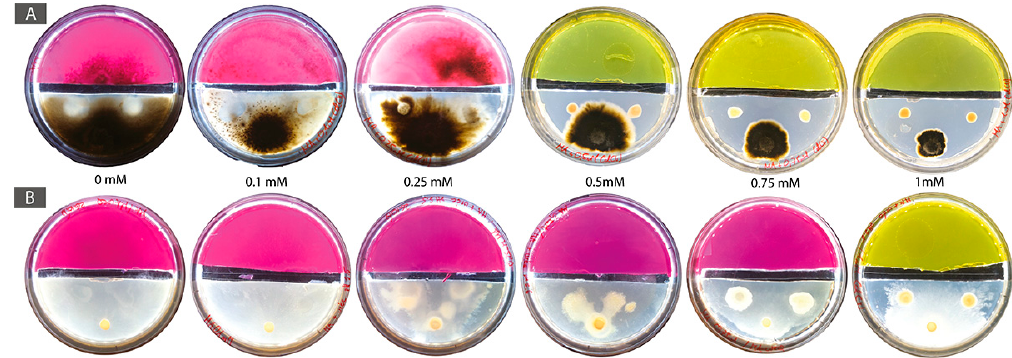
Figure A3. Experimental setting consisting of two-compartment systems in Petri dishes with a mobilization area (bottom part containing MA and Cd; 0 mM control and 0.1, 0.25, 0.5, 0.75, and 1 mM